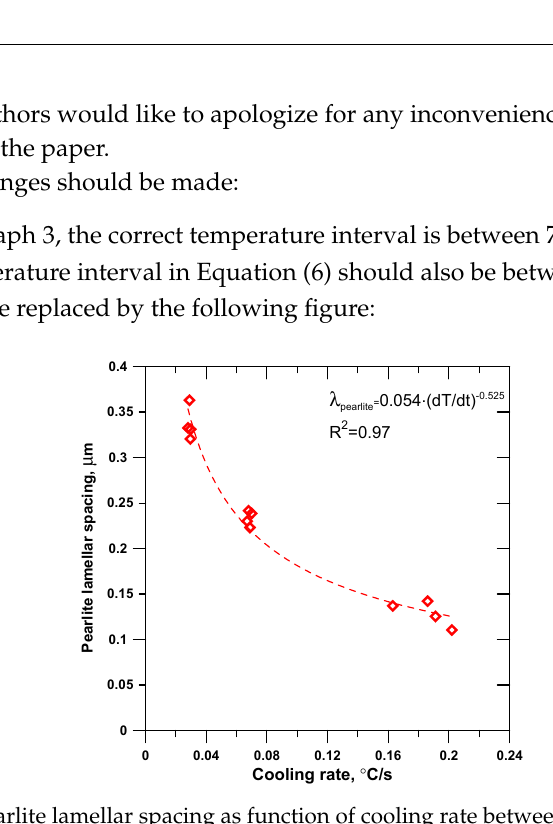
Figure 1. Pearlite lamellar spacing as function of cooling rate between 700 and 740 °C.